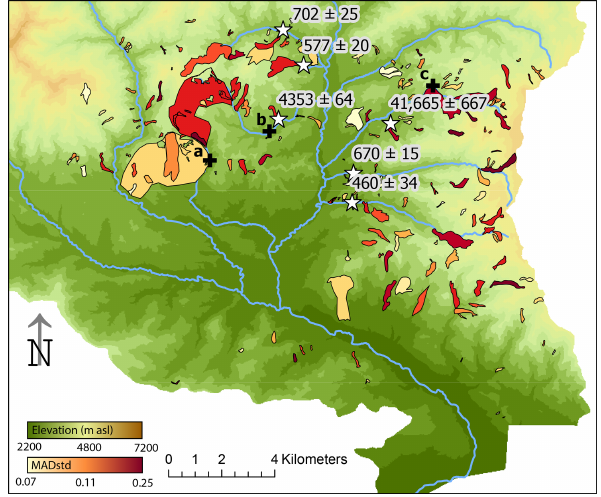
Figure 2. Earthflows mapped in the study area; earthflows are col- ored by their MADstd value. Radiocarbon locations and dates, in calibrated yrBP, are shown with white stars. Black crosses indicate locations of earthflow-dammed lakes where sedimentation ages are derived: (a) unnamed creek; (b) Rye Creek; and (c) Indian Creek. Extent of region is shown in Fig. 1. Background elevation data from Quantum Spatial (2015,